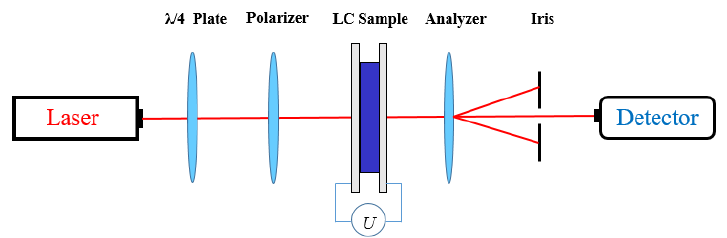
Figure 1. Optical path diagram of dynamic response.